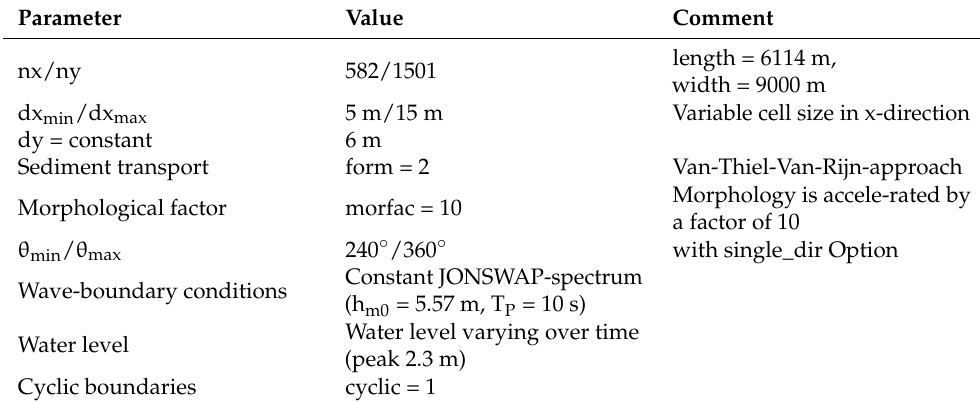
Table 2. XBeach model parameters and settings, Ahrenshoop, MV design flood.